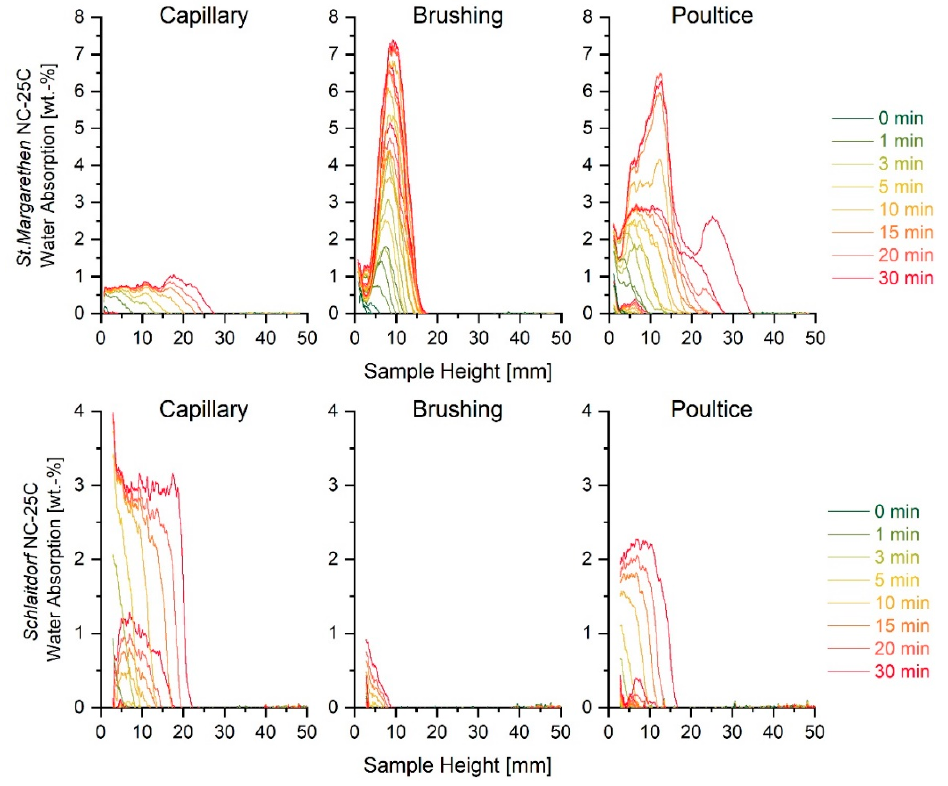
Figure 6. The top graph displays water absorption kinetics reported in weight percentage for three St. Margarethen Limestone specimens treated with NC-25C, while the bottom graph displays the same for Schlaitdorf Sandstone.